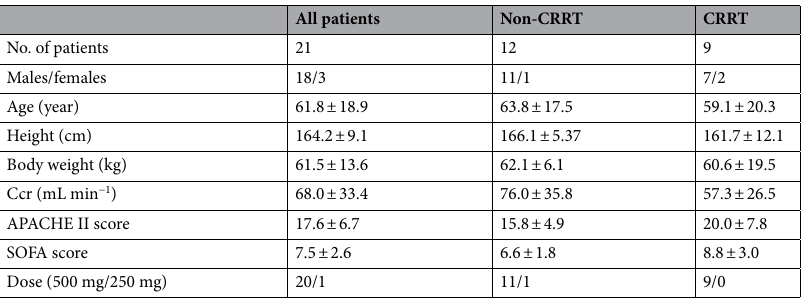
Table 1. Demographics and relevant clinical data of all patients, those who underwent continuous renal replacement therapy (CRRT) and those who did not undergo CRRT. Data are expressed as number or mean ± S.D. Ccr, creatinine clearance; CRRT, continuous renal replacement therapy; APACHE II score, acute physiology and chronic health evaluation score II; SOFA score, sequential organ failure assessment